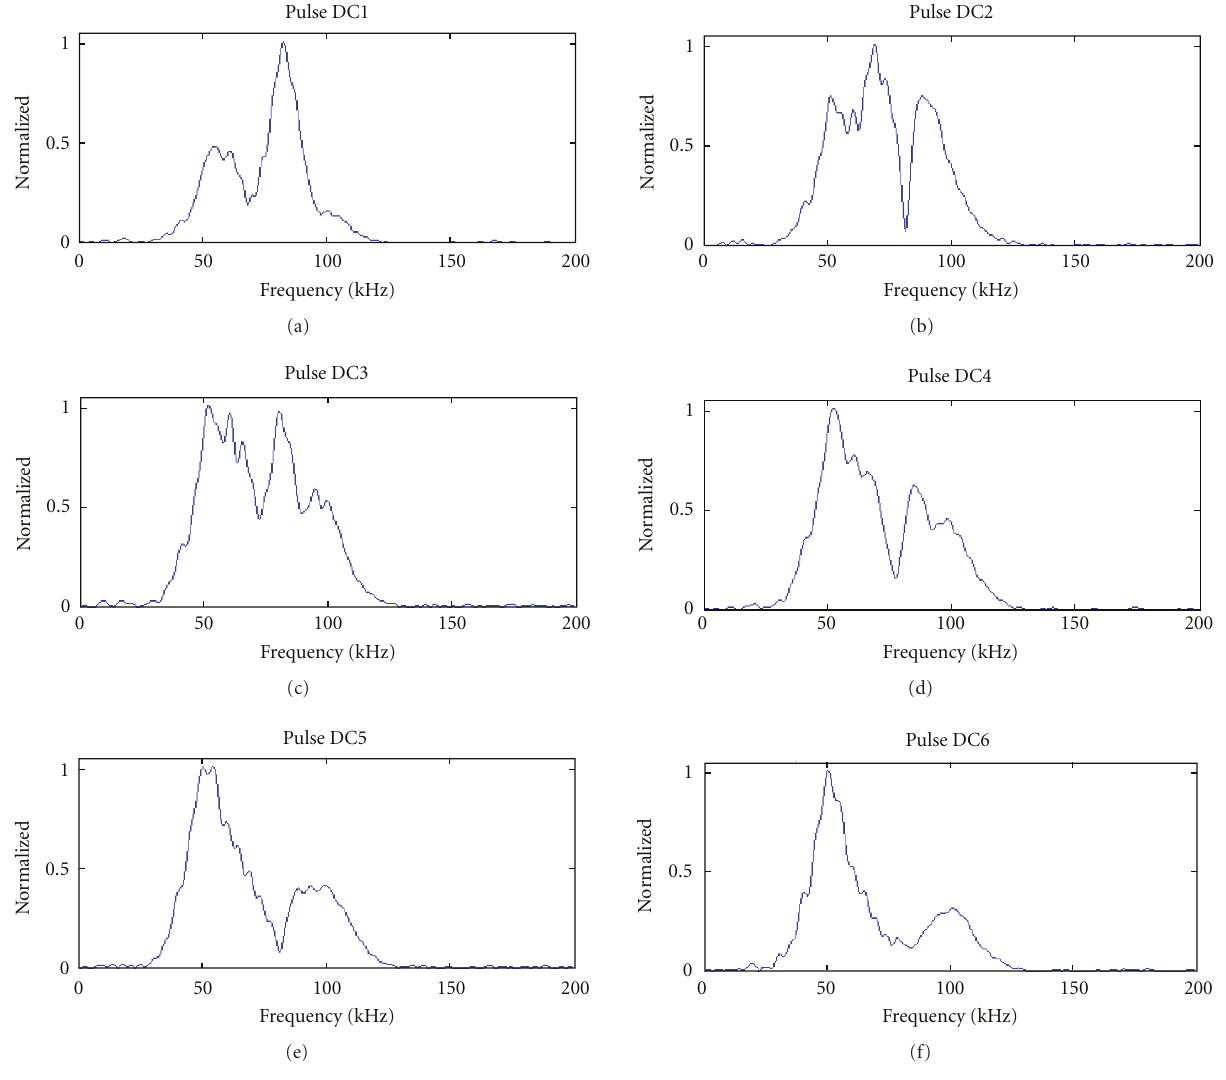
Figure 19: Spectral responses for a large concrete block, pulses